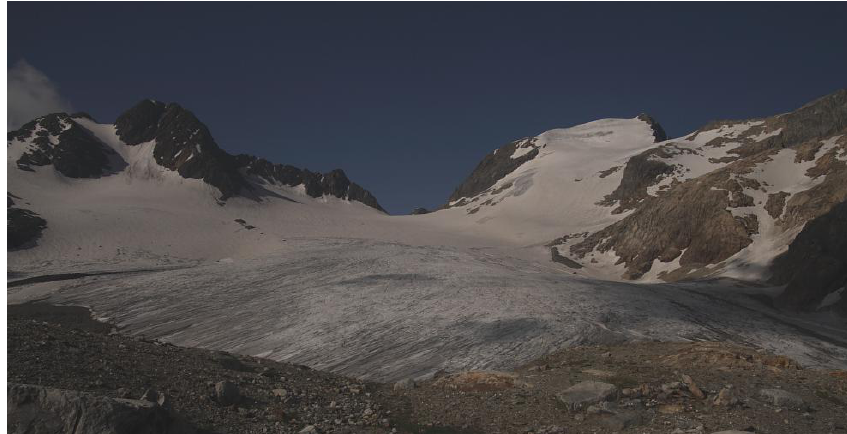
Fig. 7. Visible photography of the glacier on 3 July 2009 at 9:00